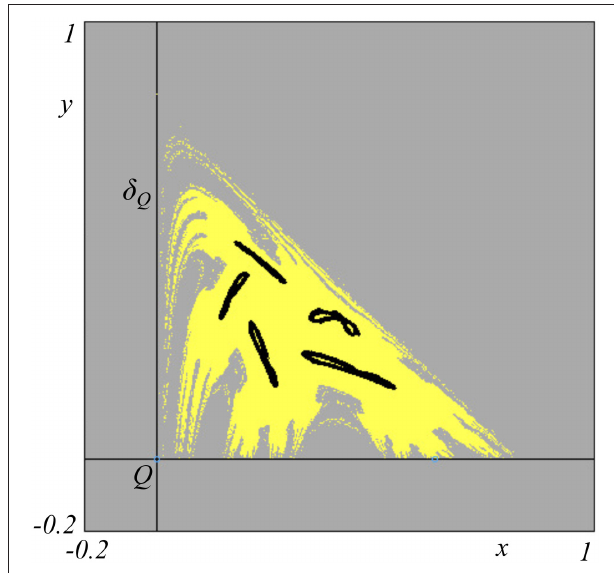
FIGURE 10 | A cyclic chaotic attractor for the map T and its related basin of attraction (yellow color). The focal point Q is on the basin boundary, but the whole singular line δ Q is not on the boundary. The gray region refers to unfeasible trajectories. Parameter values are: A